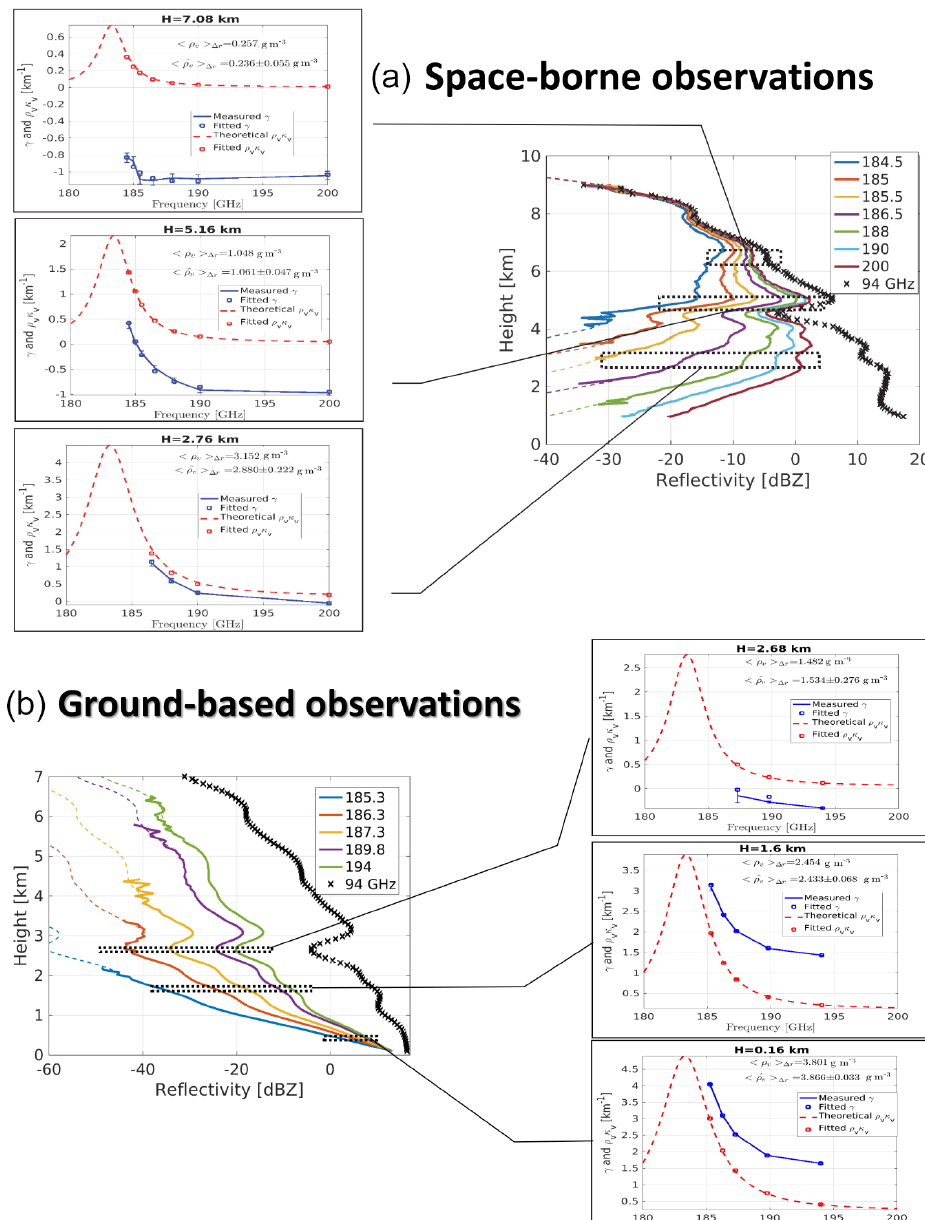
Figure 5. (a) Simulated reflectivities for the profile at latitude − 58 . 07 ◦ (black arrow in Fig. 3a) for a seven-channel space-borne DAR with frequencies on the upper wing of the 183.3GHz line. An integration length of 1.1km is assumed (corresponding to N p = 920). The CloudSat 94GHz profiles is shown for reference as well (black crosses). Continuous (dashed) lines correspond to reflectivities including (without) noise. The associated sets of three insets for each panel show examples of the fitting procedure at three different altitudes to estimate (cid:104) ρ v (cid:105) (cid:49)r with (cid:49)r = 500m. True and estimated values are inserted in the figure. (b) Same as (a) for a five-tone ground-based DAR. An integration time of 2min (corresponding to N p = 720000) and a vertical resolution of 120m are